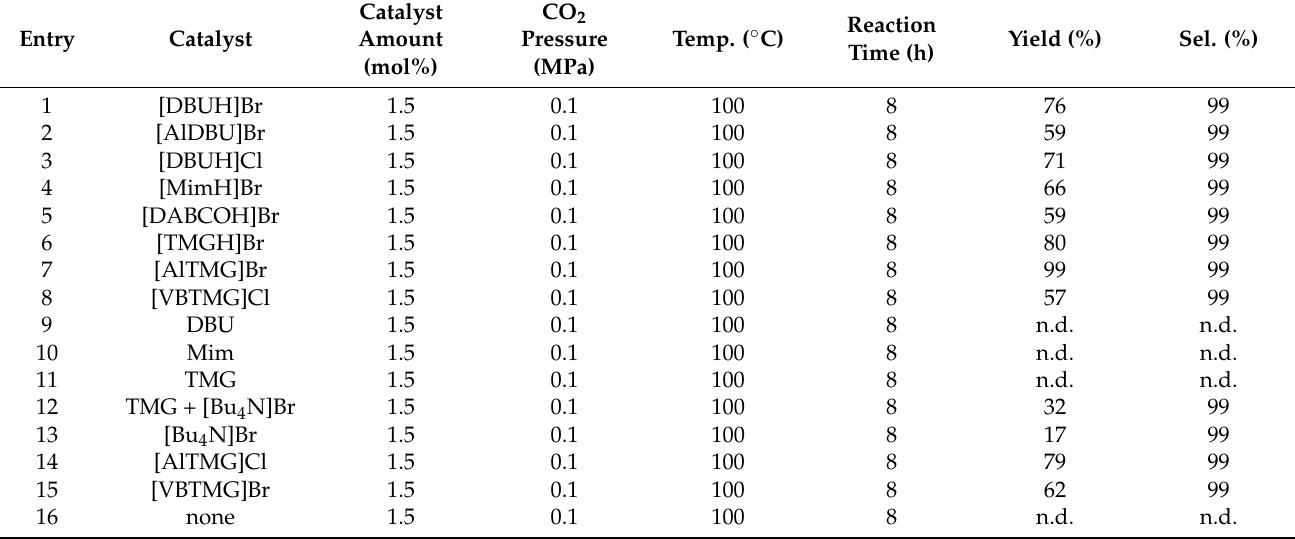
Table 25. Effect of different PILs and ILs on the carbonation of SO